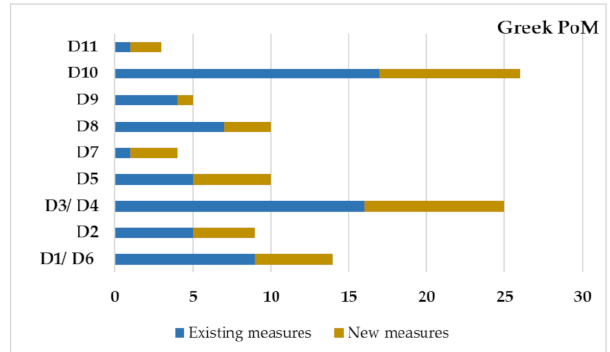
Figure 13. Existing and new measures per descriptor contained in the PoM as reported by Greece in the first MSFD